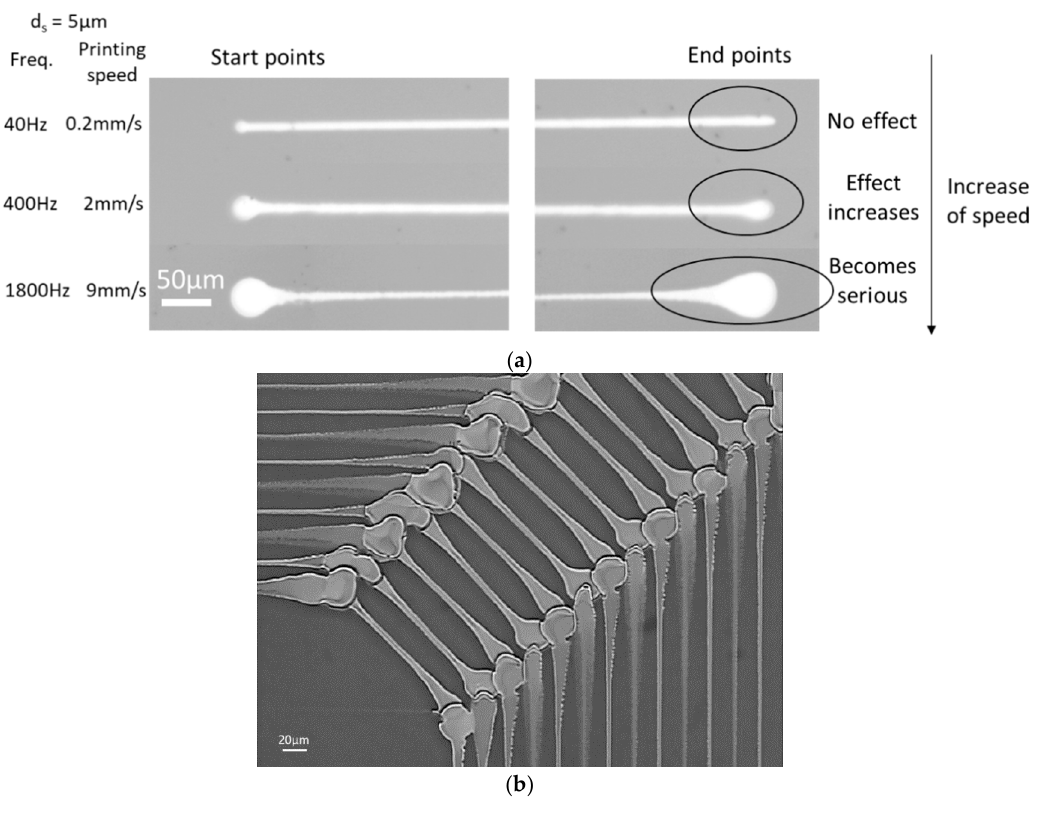
Figure 3. Non-uniform effect of vector printing on printed patterns. ( a ) Printing speed effects on dot size; ( b ) typcial printed lines using a printing speed of 30 mm/s.